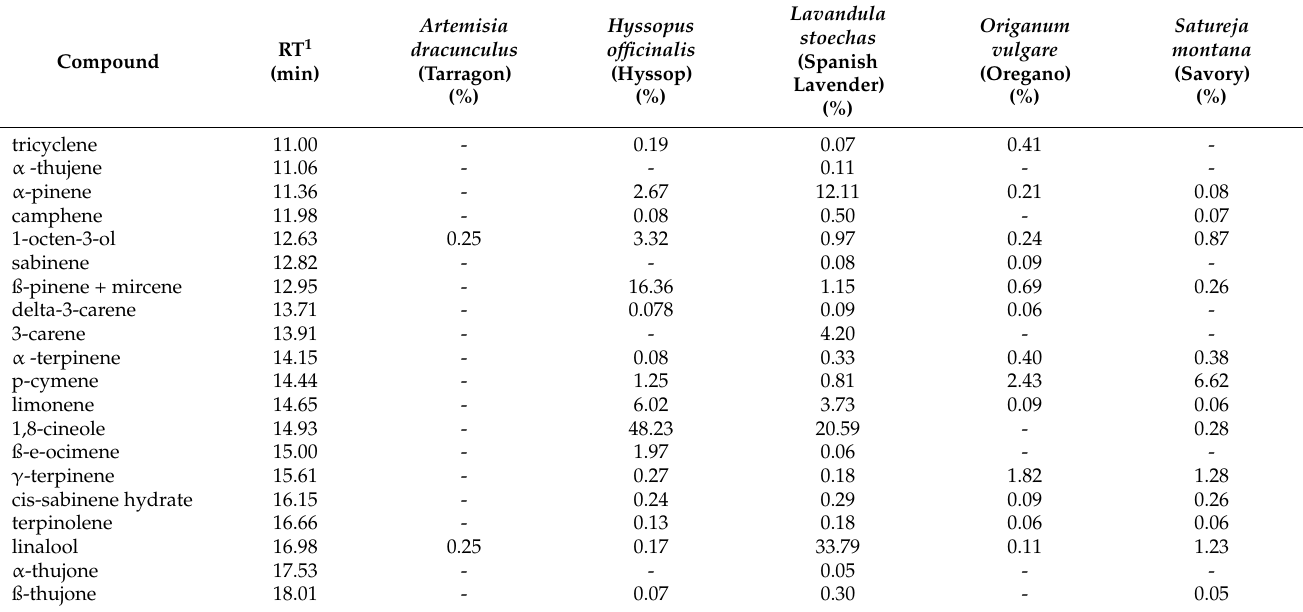
Table 2. Chemical composition of essentials oil from aromatic plants (area